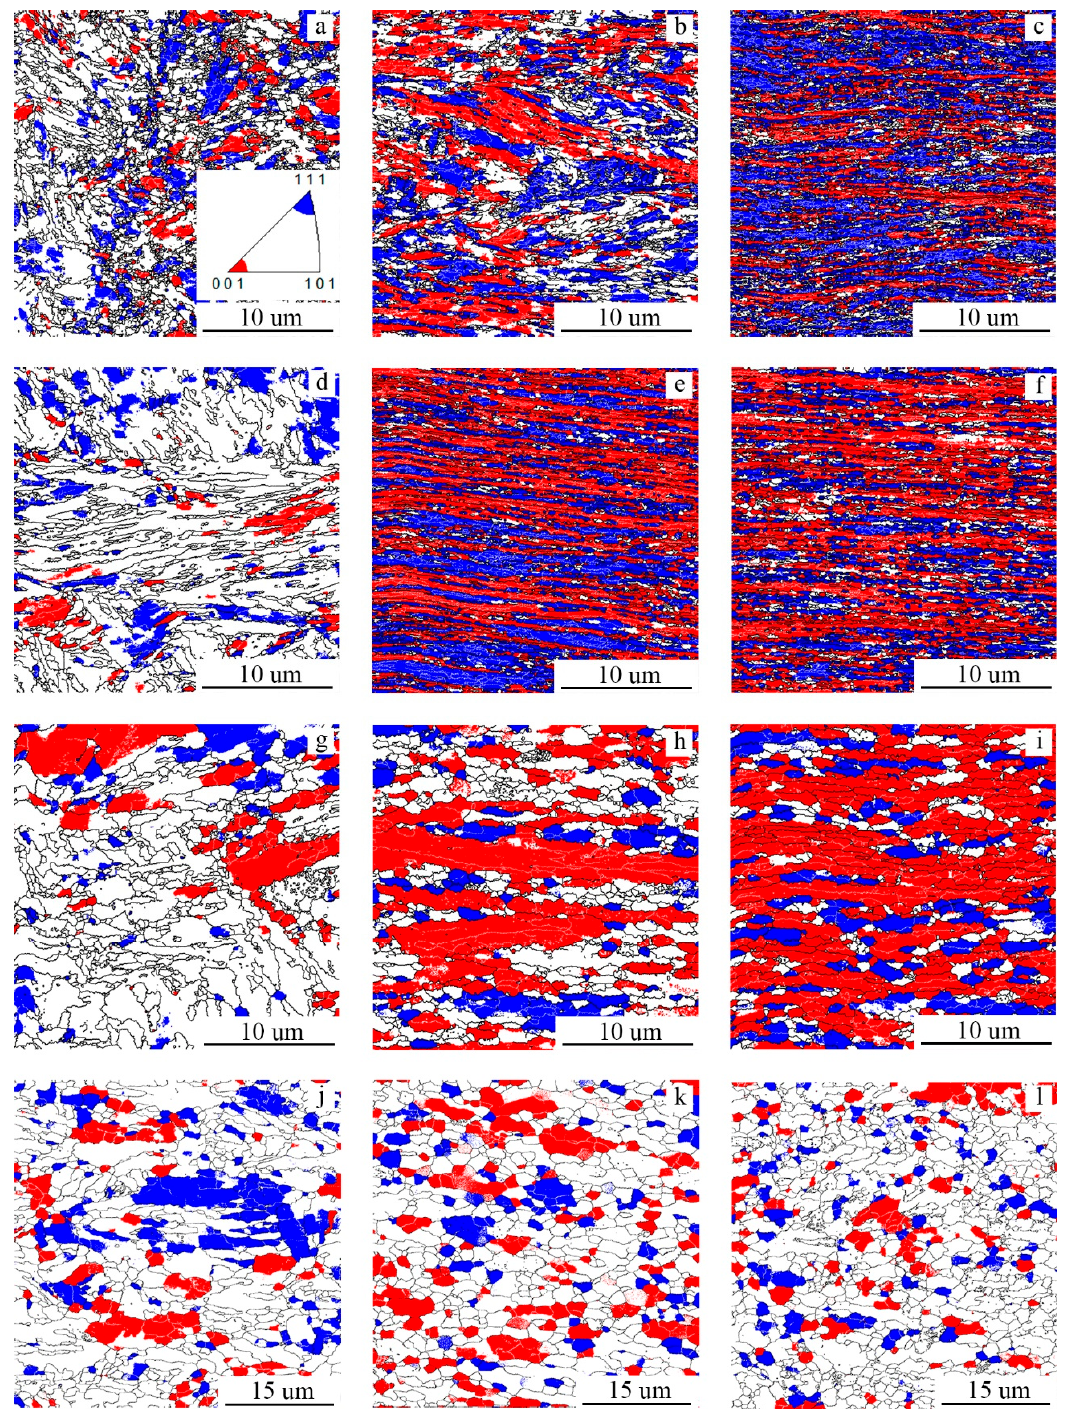
Figure 6. Texture component maps after deformation with a strain rate of 1.3·10 − 3 s − 1 at 400 ( a – c ), 500 ( d – f ), 600 ( g – i ) or 700 °C ( j – l ) to ε = 0.3, 0.77 or 1.15. Notation: high-angle boundaries (with misorientations ≥ 15°) are black, low-angle boundaries (with misorientations 2–15°) are white. Color code is shown in Figure 6a. The compression axis is vertical in all cases.